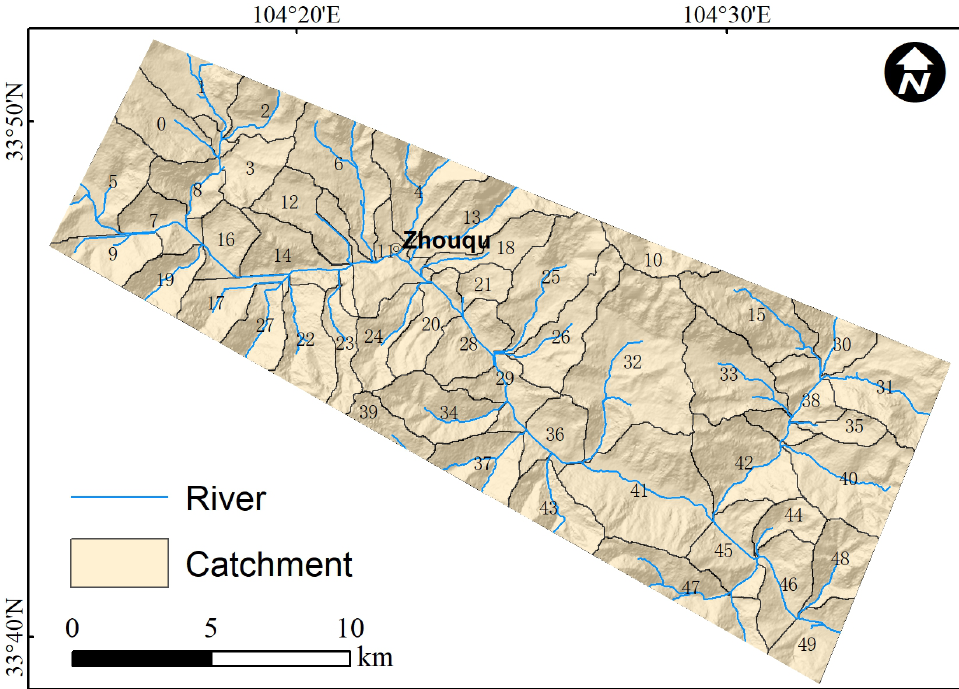
Figure 6. Regional division by river catchment in Zhouqu